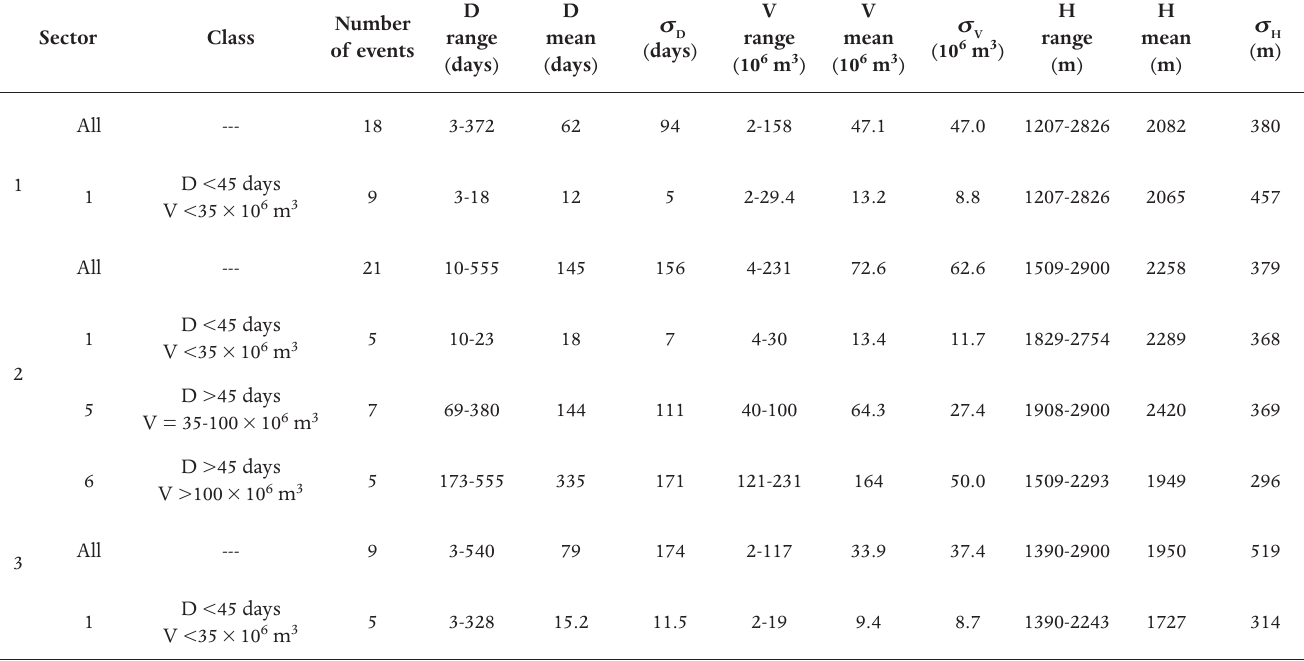
Table 2. Number of events, ranges, means and standard deviations ( v ) of durations (D), volumes (V) and elevations of the main vent (H) for all the events and the most recurrent classes in each